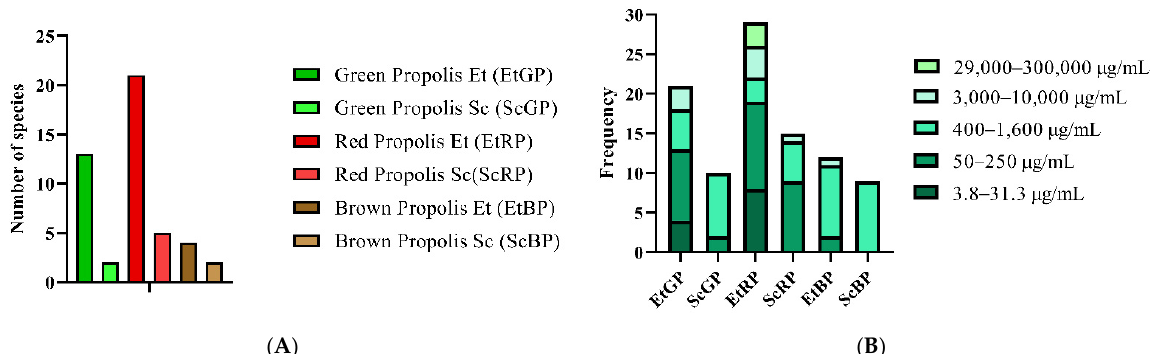
Figure 2. Antimicrobial activity of Brazilian propolis against different microorganisms. ( A ) Several microbial species inhibited by different propolis extracts: Ethanolic (Et) and Supercritical (Sc). ( B ) Distribution of the Minimal Inhibitory Concentrations (MICs) found in the 13 studies evaluated. Frequency: number of MICs found in that interval. EtGP, ScGP, EtRP, ScRP, EtBP and